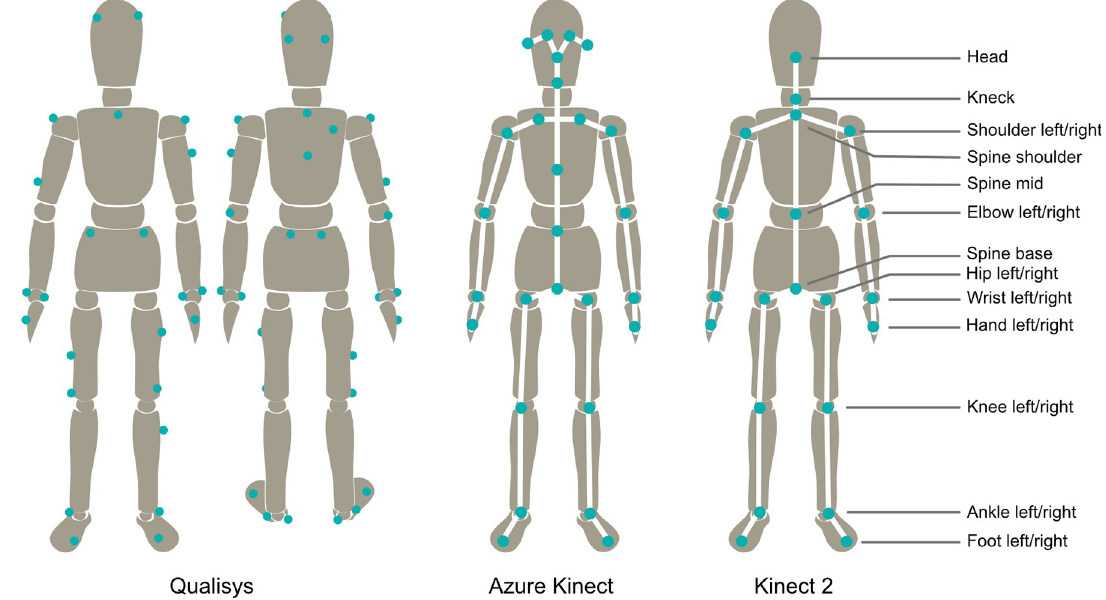
Fig 2. Locations of Qualisys markers and artificial anatomical landmarks from the Kinect 2 and Azure Kinect.